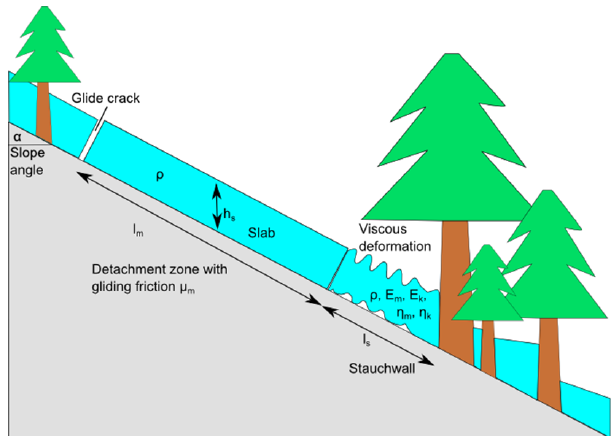
Figure 7. Model description: a slab with length l m , snow density ρ and snow depth h s starts to glide on a slope with angle α . A glide crack opens and the weight of the slab m is balanced by the friction of the snow on the ground µ m and the stauchwall with length l s , snow density ρ and material parameters E k ,E m ,η k , and η m